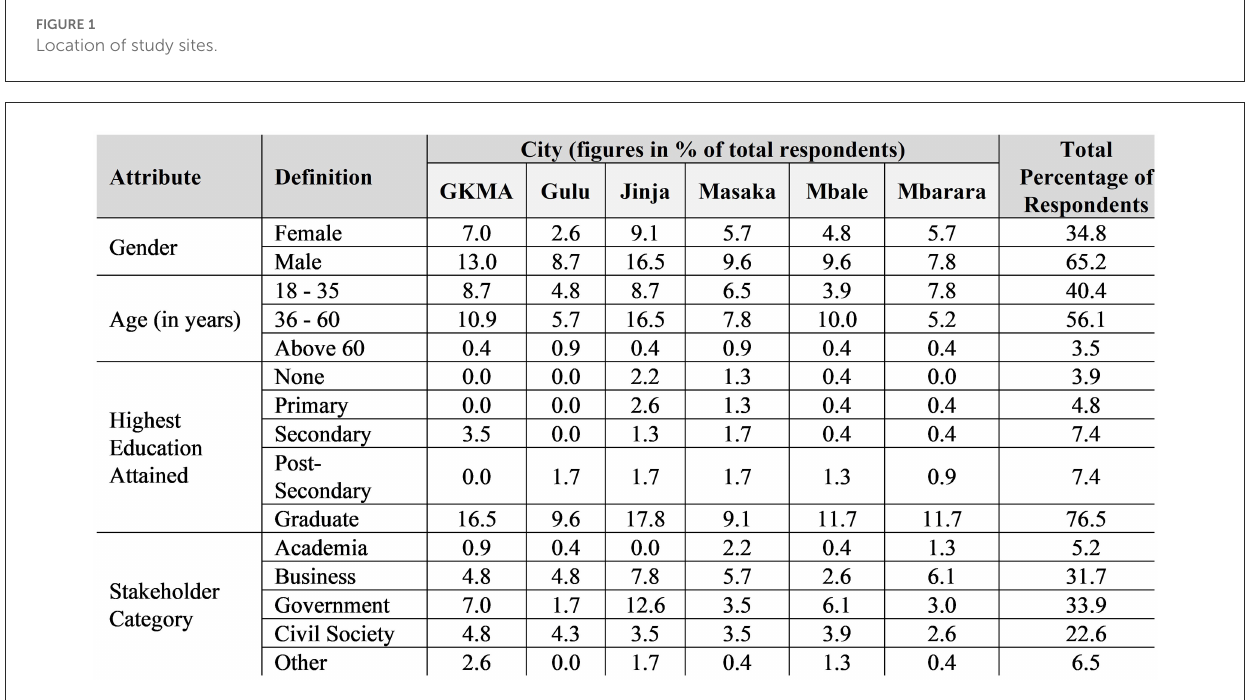
FIGURE2 Socio-demographic attributes of